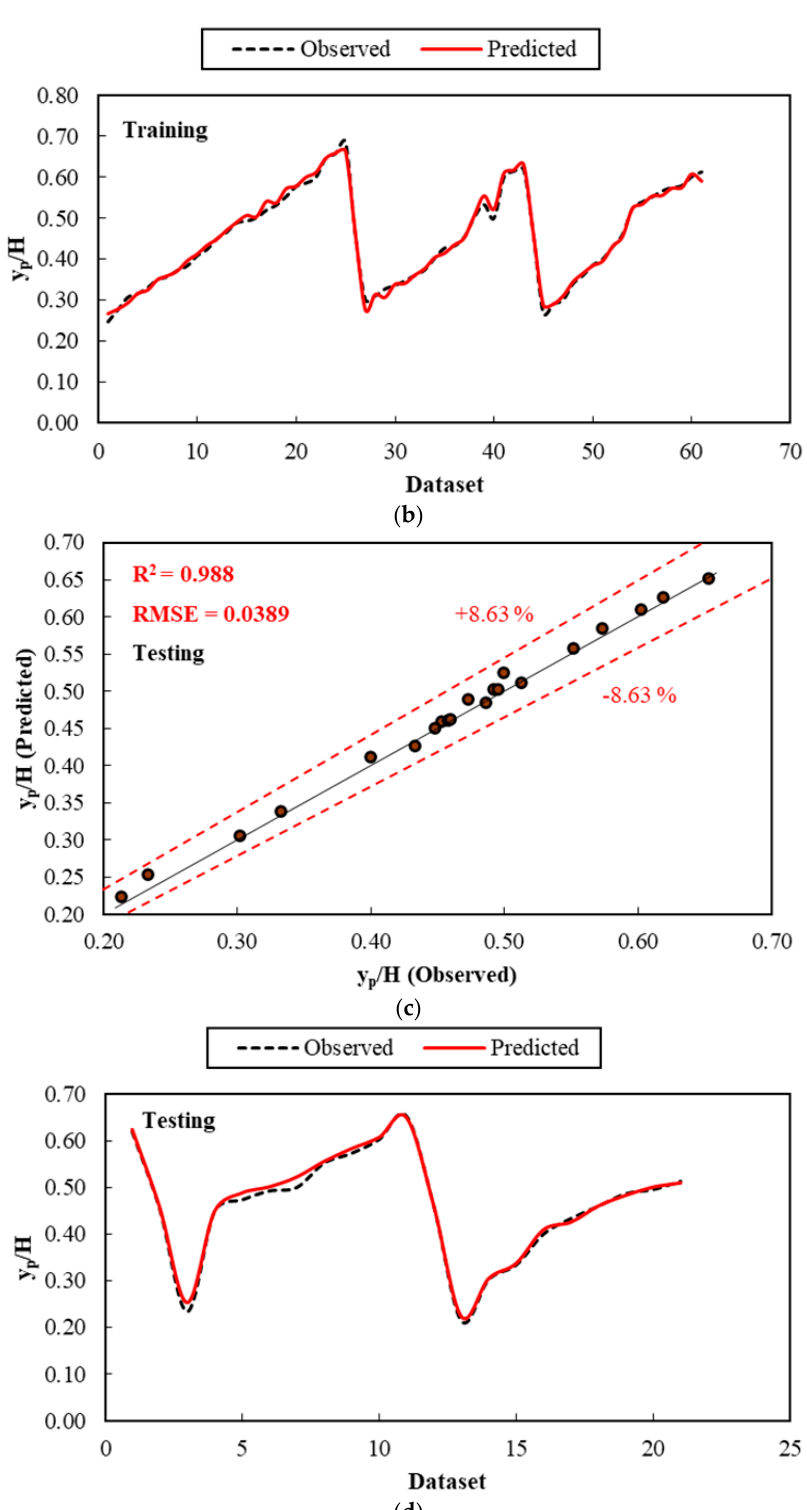
Figure 8. Comparison of the observed and predicted energy dissipation values for model 3 in the second scenario. ( a , b ) training; ( c , d ) testing.